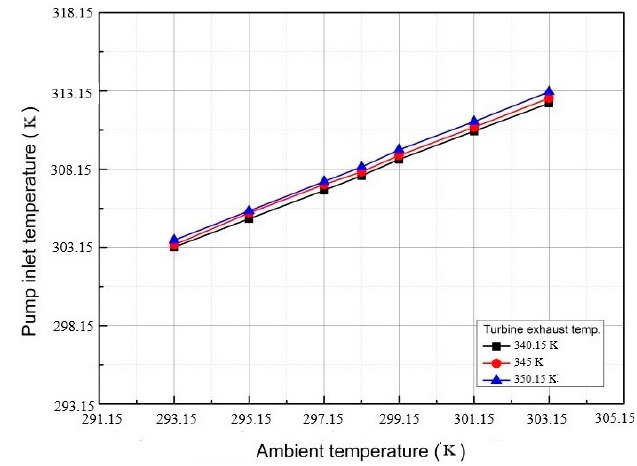
Figure 13. Outlet temperature of CO 2 in the condenser at different ambient temperatures.